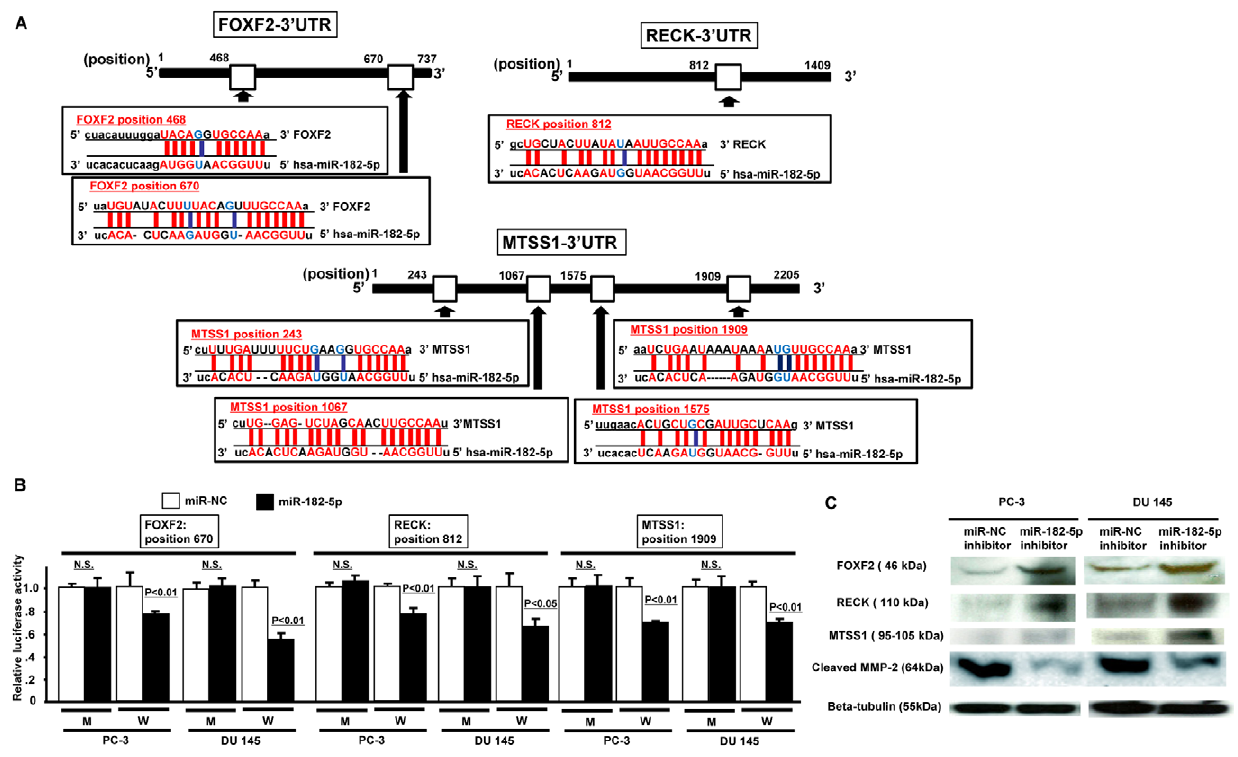
Figure 4. miR-182-5p binds to the 3’ UTR of FOXF2, RECK and MTSS1 mRNAs and down-regulates expression. A. FOXF2, RECK and MTSS1 3’UTR position and complementary miR-182-5p sequence. B. 3’UTR Luciferase assay (miR-NC and miR-182-5p precursor), Error bars represent 6 S.D. (standard deviation). C. Protein expression of FOXF2, RECK, MTSS1, MMP-2 and beta-tubulin in miR-NC inhibitor or miR-182-5p inhibitor transfected prostate cancer cells (PC-3,